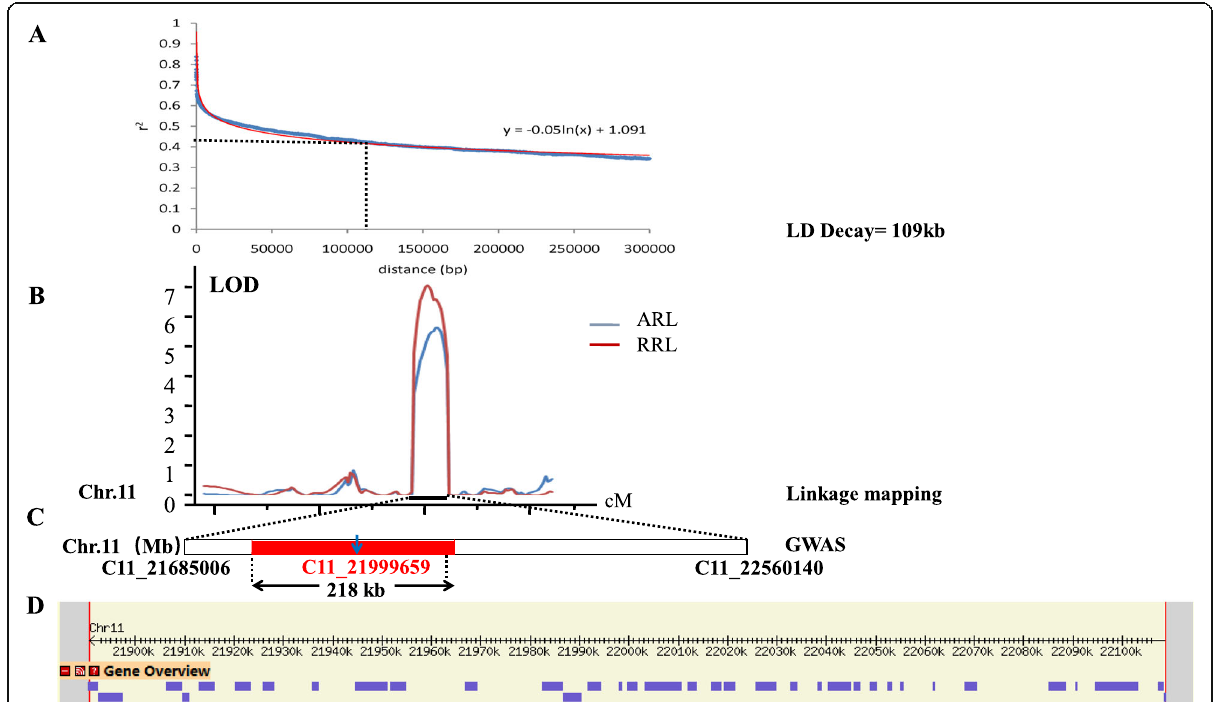
Fig. 3 Identification of candidate genes by linkage mapping and GWAS. a LD decay analysis of the whole genome in 295 japonica rice varieties. When r 2 decays to half of the maximum value, the corresponding physical distance (109 kb) is recorded as the LD attenuation distance of the whole genome. b A QTL related to alkali tolerance on chromosome 11 was identified in 184 RILs and mapped to the interval between the markers C11_21685006 and C11_22560140 by linkage mapping. c Physical location of the lead SNP (C11_21,999,659) on chromosome 11 detected by the GWAS. d 35 genes in the 218 kb